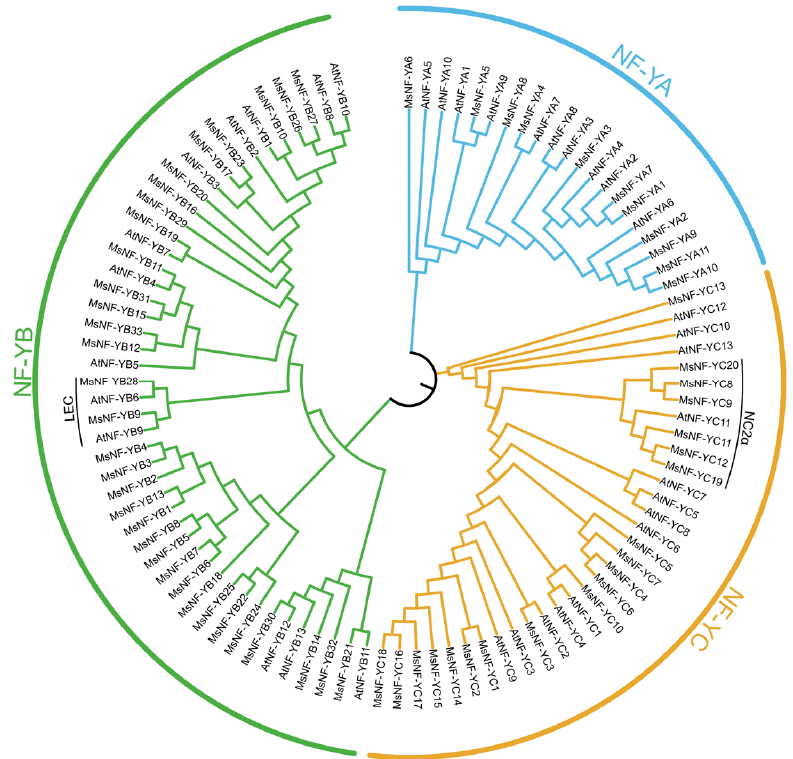
Figure 1. Phylogenetic tree of NF-YA , NF-YB and NF-YC sequences from Medicago sativa and Ara- bidopsis thaliana . The blue, green and yellow lines and branches respectively represent the NF-YA, NF-YB and NF-YC families.